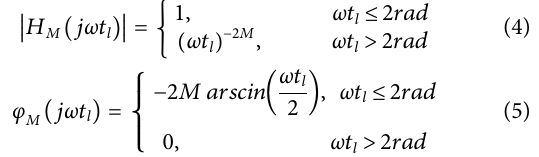
Frontiers in Energy Research |